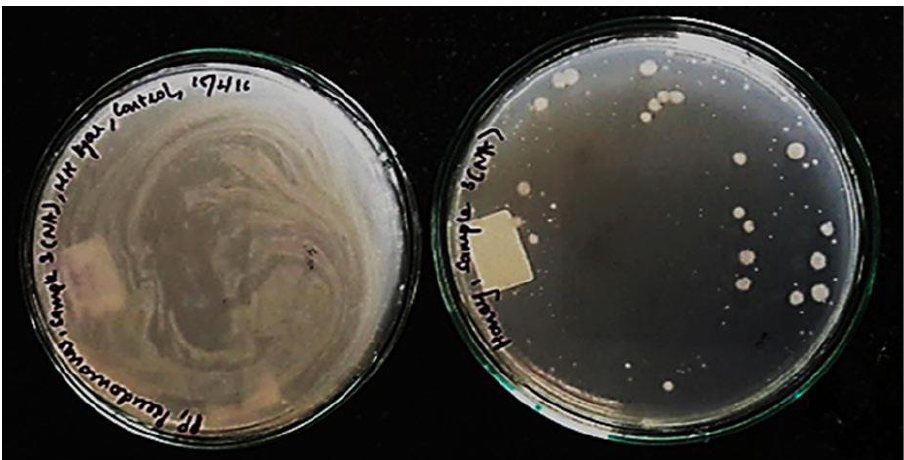
Fig. 6. Antibacterial activity of cow urine and honey mediated Ag NPs (Reproduced from ref. 44)